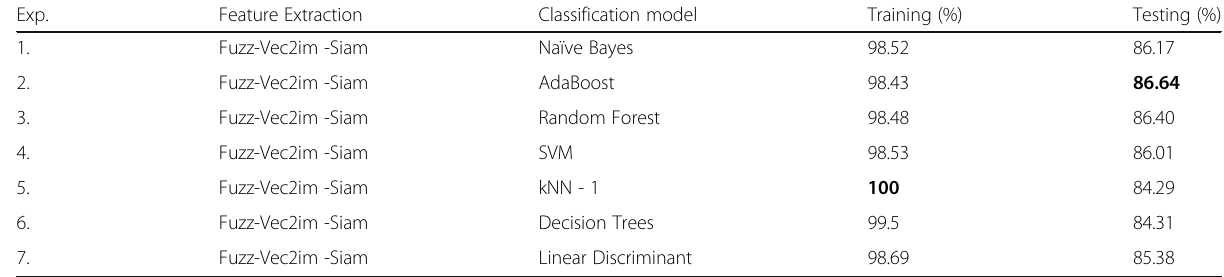
Table 1 Comparative analysis with respect to optimal choice of the machine learning model Exp.